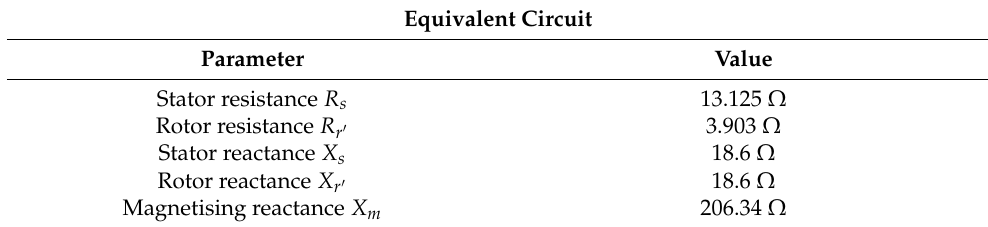
Table 10. Electrical parameters of the asymmetrical nine-phase IM.